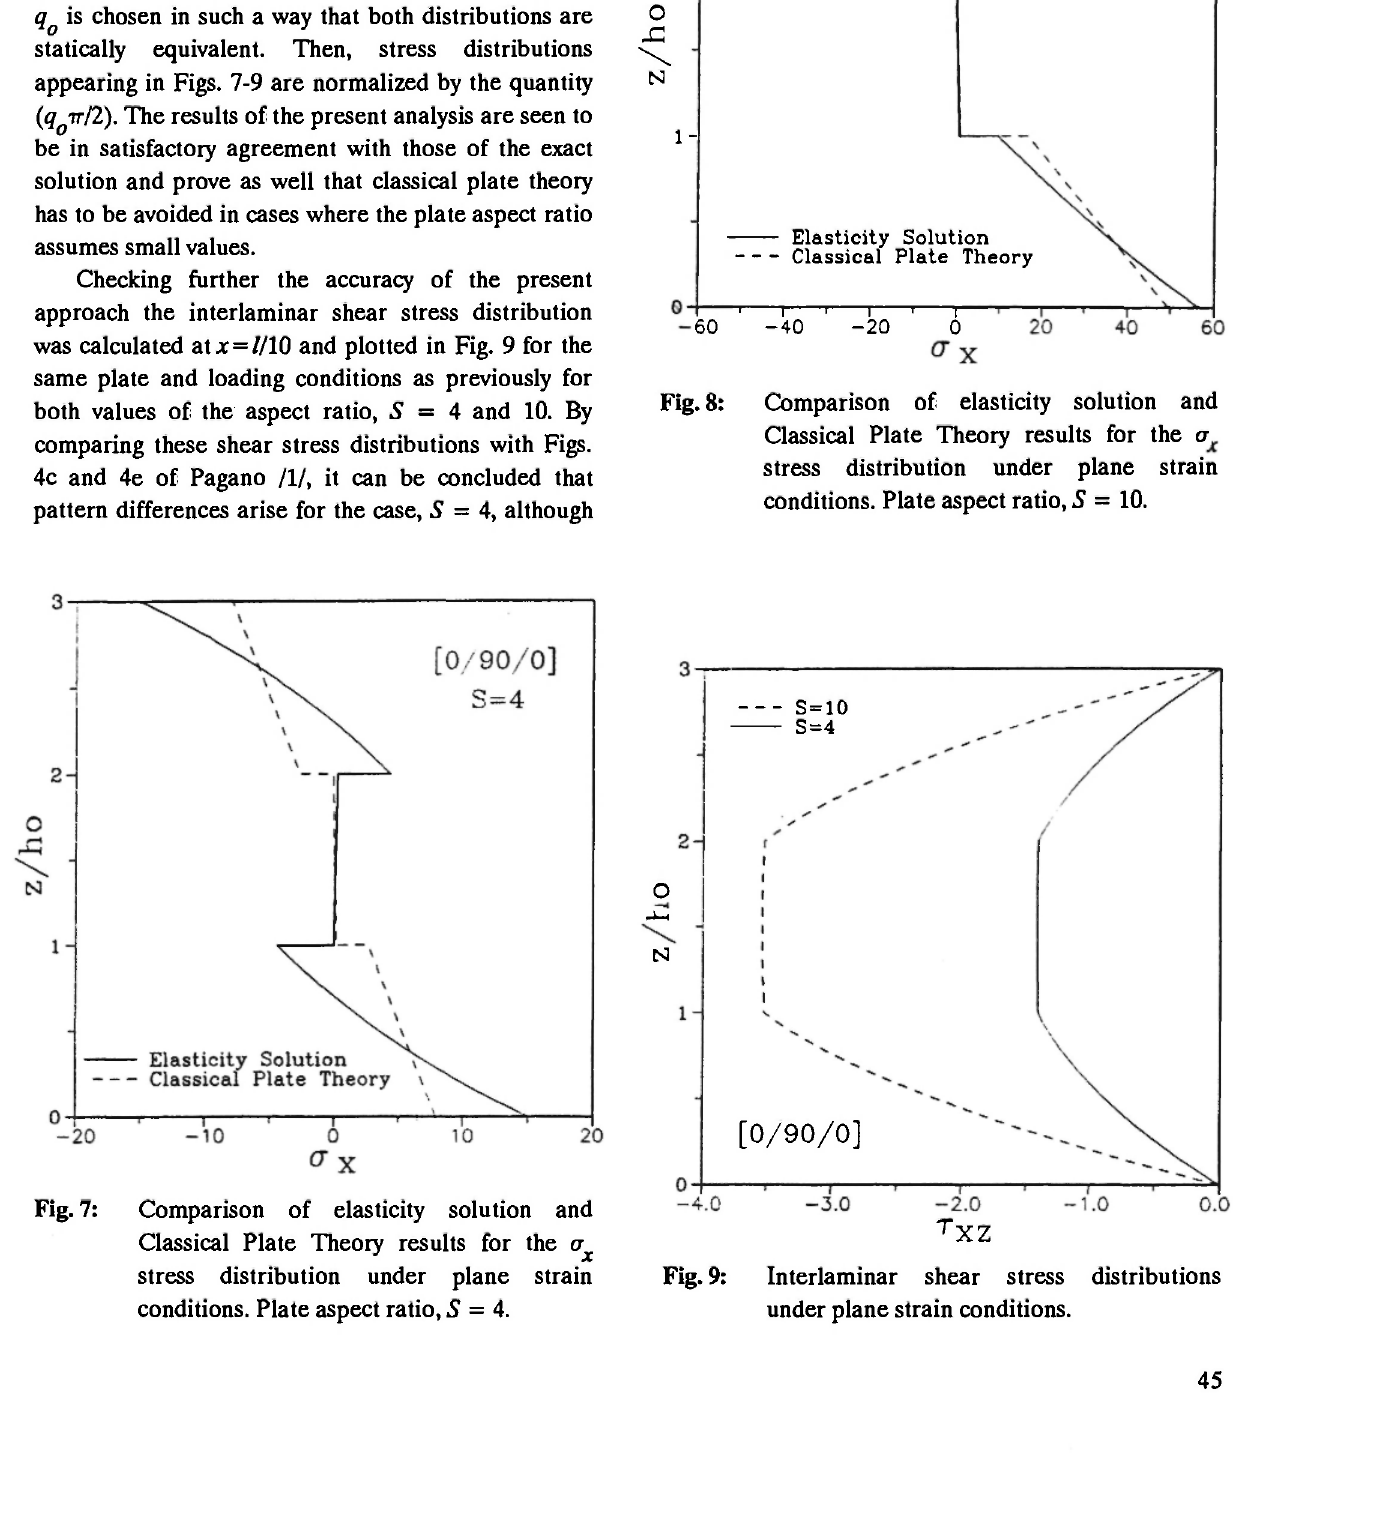
Fig. 9: Interlaminar shear stress distributions under plane strain conditions.